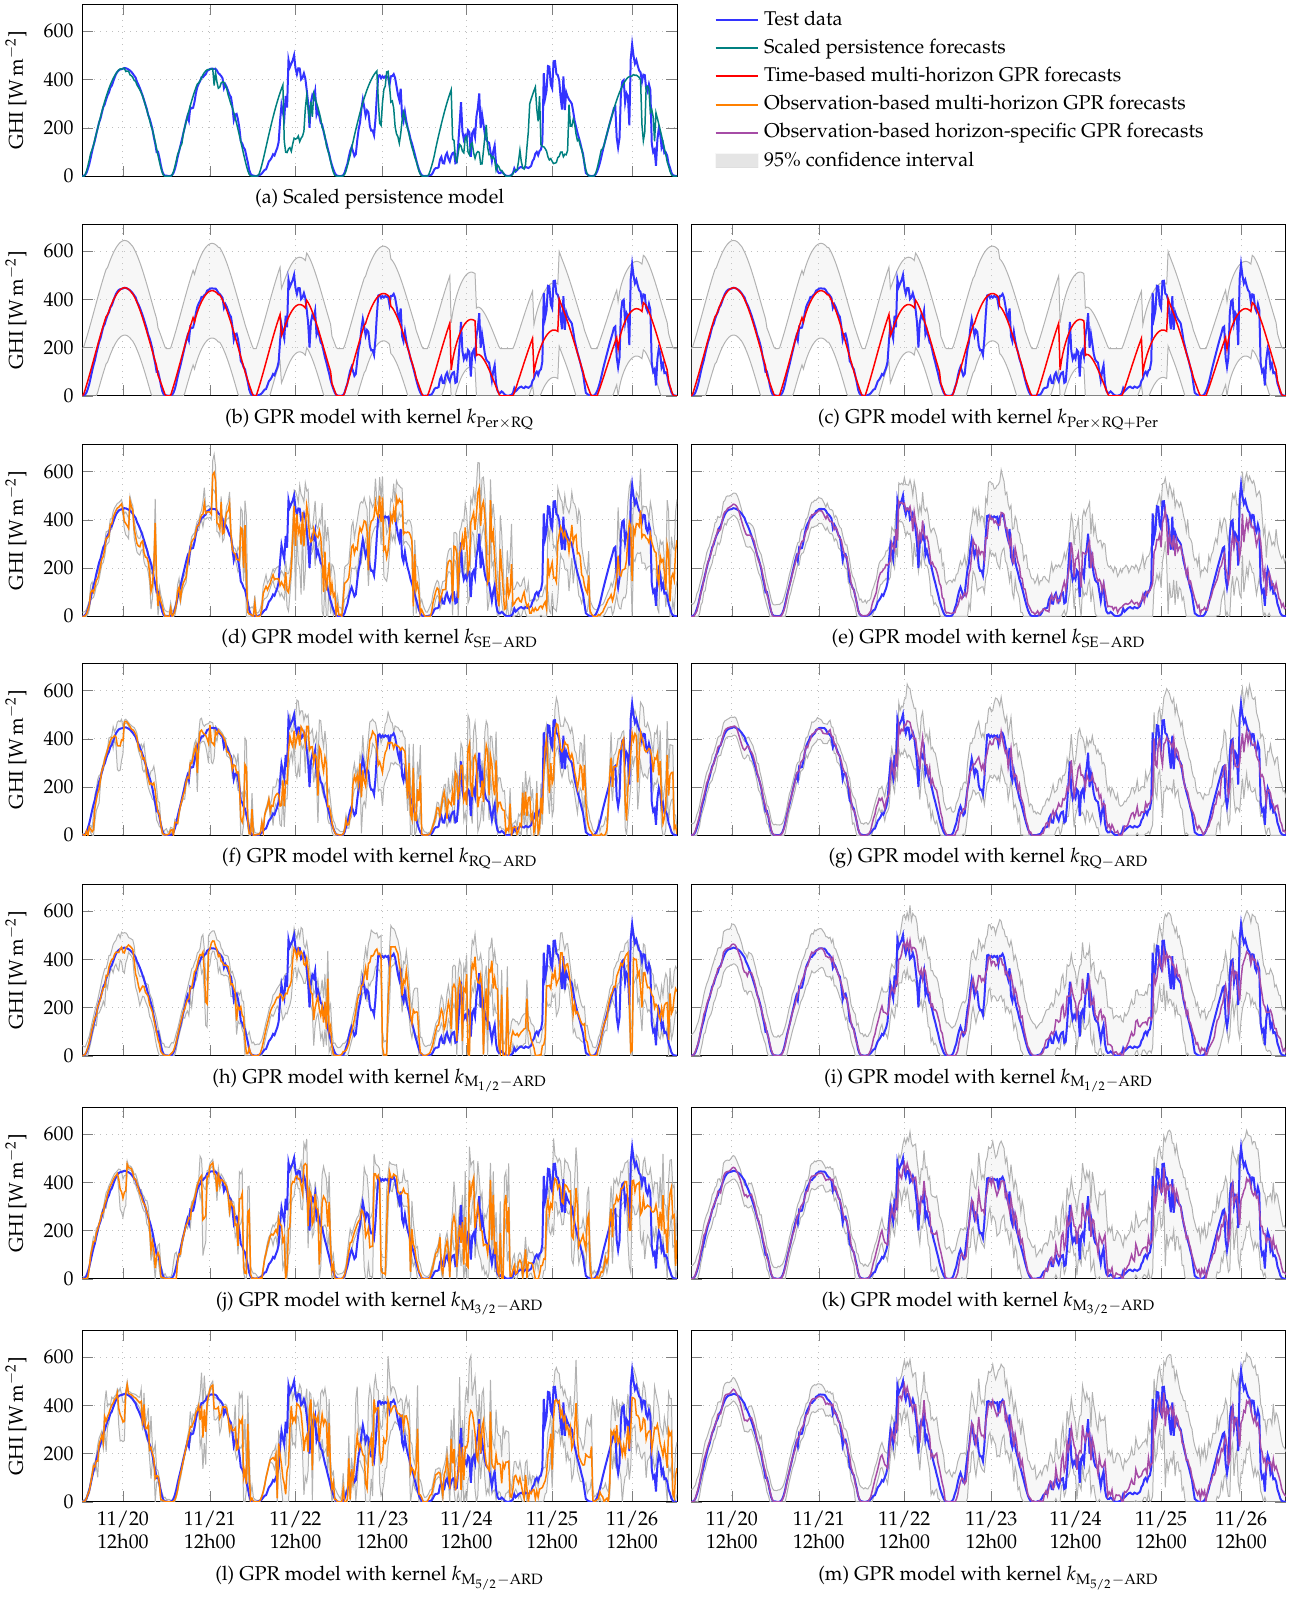
Figure 13. Examples of 3 h GHI forecasts over one week, given by the scaled persistence model and the GPR models included in this